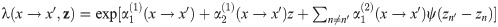
Two interacting ants.The ants follow dynamics of Eq (10) where the stochastic switching between the states follows transition rates λ(x→x′,z)=exp[α1(1)(x→x′)+α2(1)(x→x′)z+∑n≠n′α1(2)(x→x′)ψ(zn′-zn)] with α1(1) and α2(1) the same as for the single ant in Fig 4 and the interaction strength α1(2)(x→x′)=0.5. The interaction with a kernel ψ(d) = e−d2 modulates the rates multiplicatively by a factor which increases all transition rates when ants are close to each other and leaves them unchanged when they are sufficiently distant. (A) Short stochastic simulation of two interacting ants, showing also the instantaneous transition rates from the current state. The interaction modulating factor exp(0.5ψ(d)) is shown together with other transition rates (green) using the same axis. (B) The first and the second rows show the inferred transition rates (dots) for the parameters α(1) and α(2), respectively, compared with the exact rates (solid curves). The inference is based on 500 simulated trajectories, each for T ∈ [0, 500]. We used the tiling functions in the z and Δz = zn − zn′ space and a penalization function of the form ∑j(exp(αj(2))-1)2 to enforce vanishing interaction outside of the range |Δz| > 2. Penalization term also avoids a degeneracy of the rates, ensuring existence of a unique solution of the inference problem.